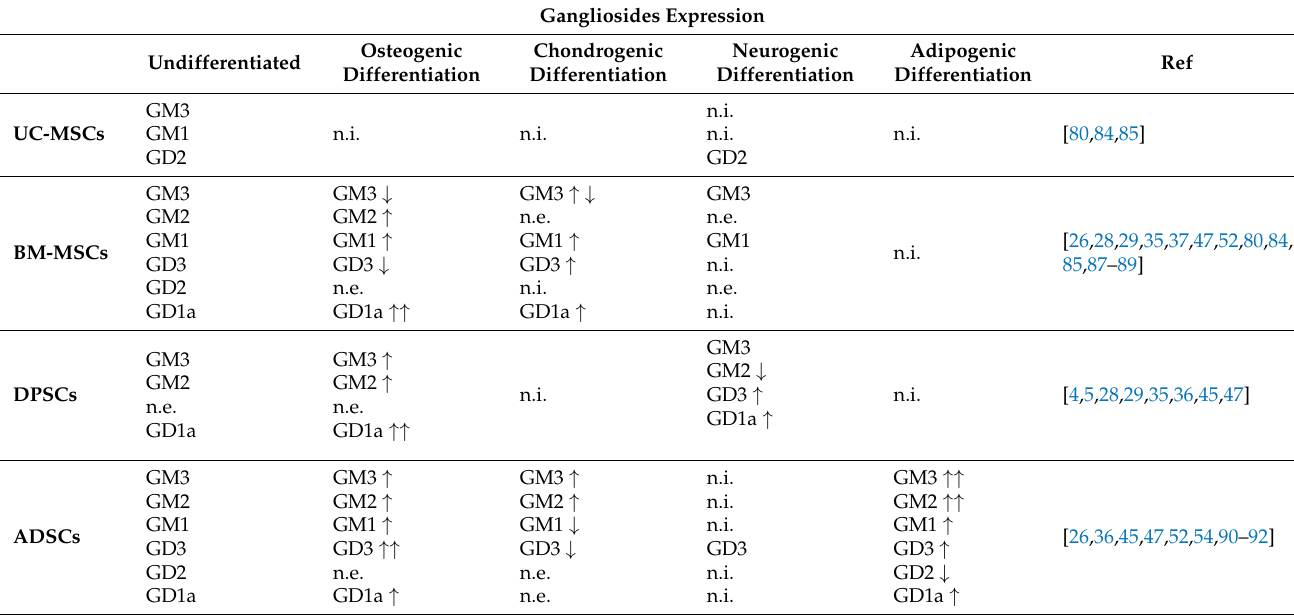
Table 2. Change in gangliosides pattern during multilineage differentiation of MSCs. Gangliosides